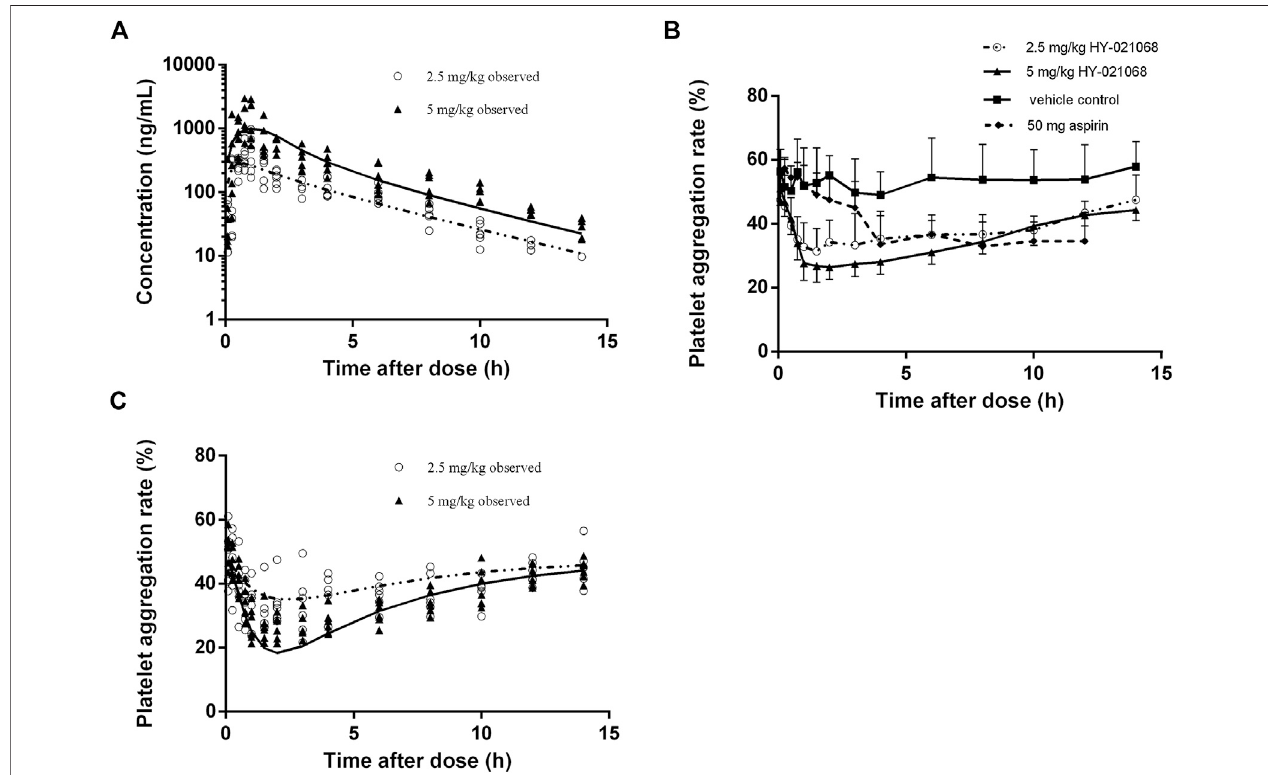
FIGURE 3 | Observed plasma HY-021068 concentration (A) and platelet aggregation rate (PAR) (C) after a single oral dose of 2.5 mg/kg (open circles, n (cid:2) 6) and the fi rst administration of multiple doses of 5 mg/kg HY-021068 (triangles, n (cid:2) 6) to beagle dogs. Curves depict population fi ttings. (Solid line: 2.5 mg/kg; dashed line: 5 mg/kg). (B) Time course of PAR in beagle dogs after oral administration of 2.5 mg/kg HY-021068 (open circles, mean ± SD, n (cid:2) 6), 5 mg/kg HY-021068 (triangles, mean ± SD, n (cid:2) 6), 50 mg aspirin (diamond, mean ± SD, n (cid:2) 6) or vehicle (square, mean ± SD, n (cid:2) 6).